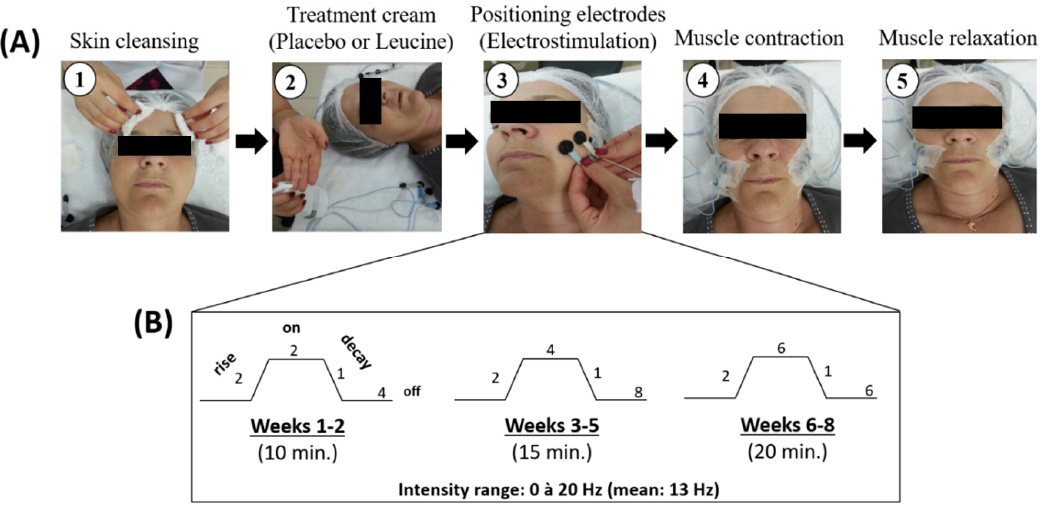
Figure 3. Steps (1 to 5) of intervention ( A ) and current Russian protocol ( B ) during the 8 weeks experimental period (total: 24 sessions).